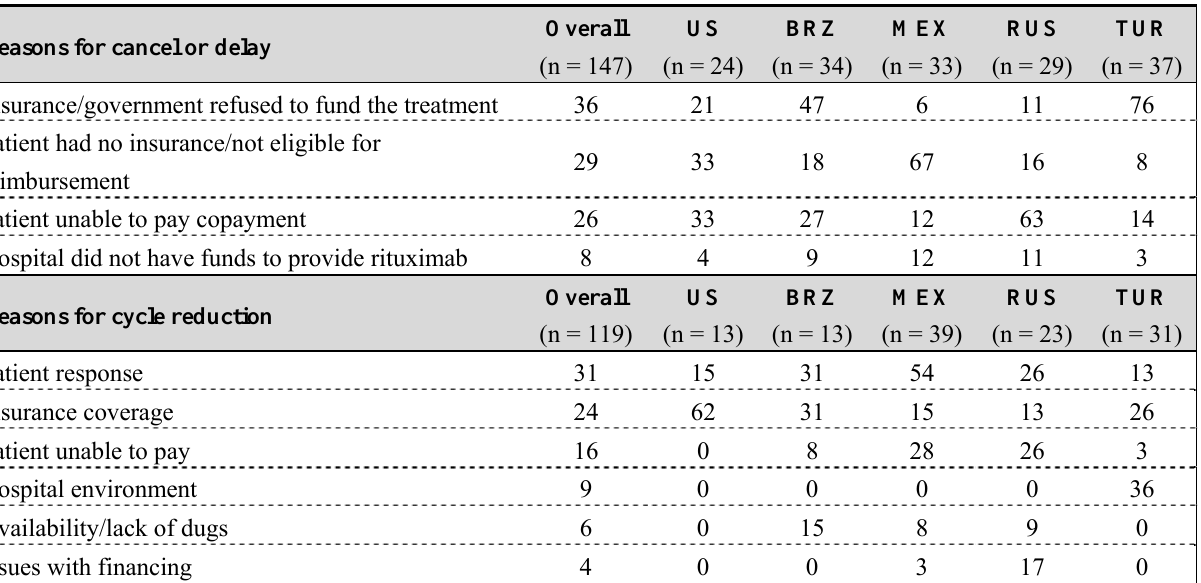
Table 4. Most common reasons physicians had to cancel, delay, or reduce treatment with rituximab (% of physicians) a